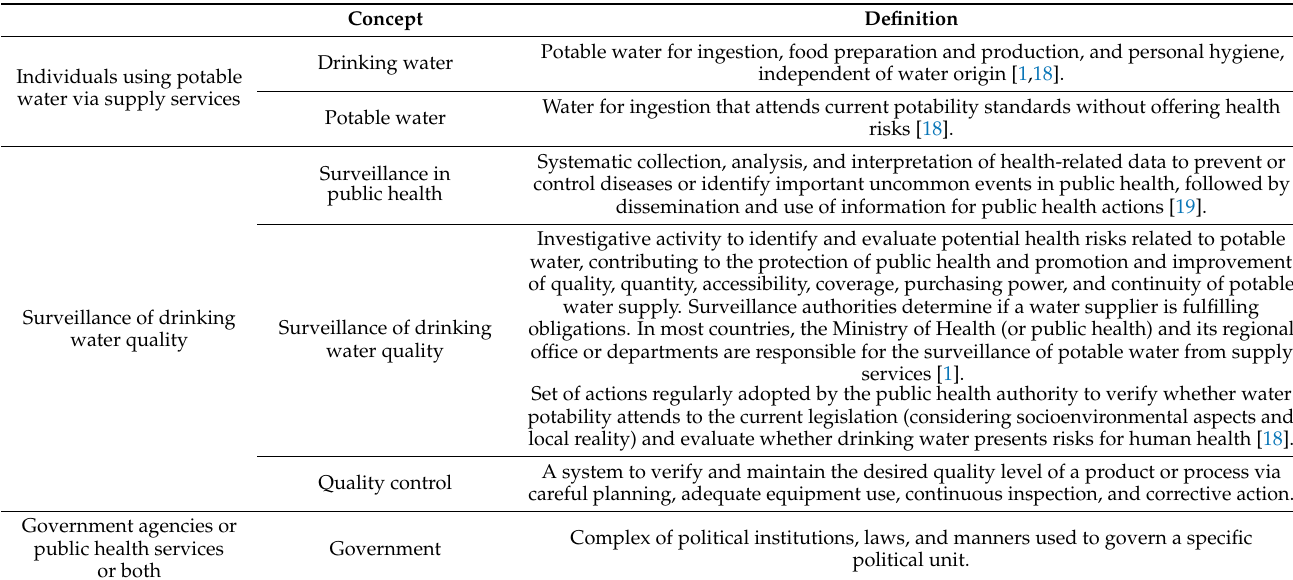
Table 1. Definition of concepts to be used in the review.